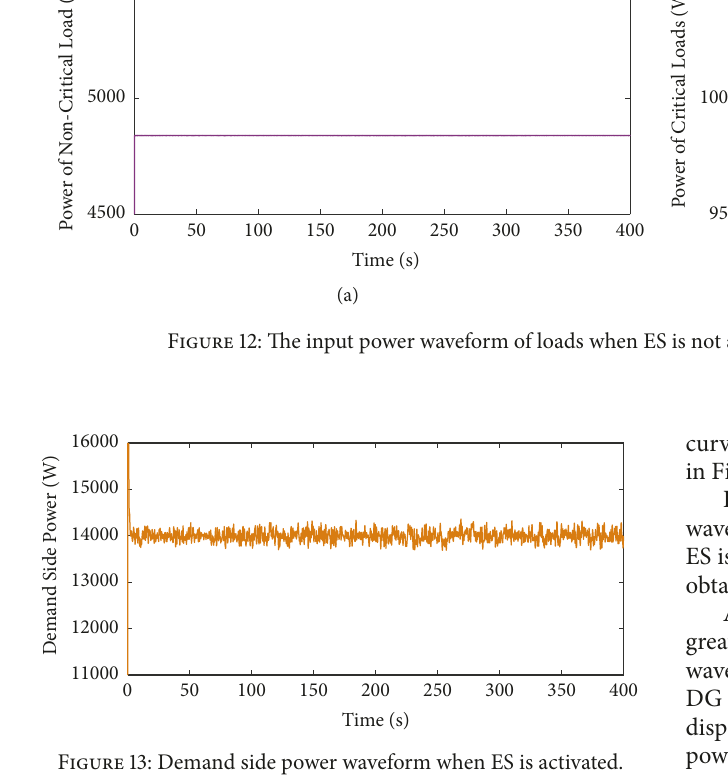
Figure 13: Demand side power waveform when ES is